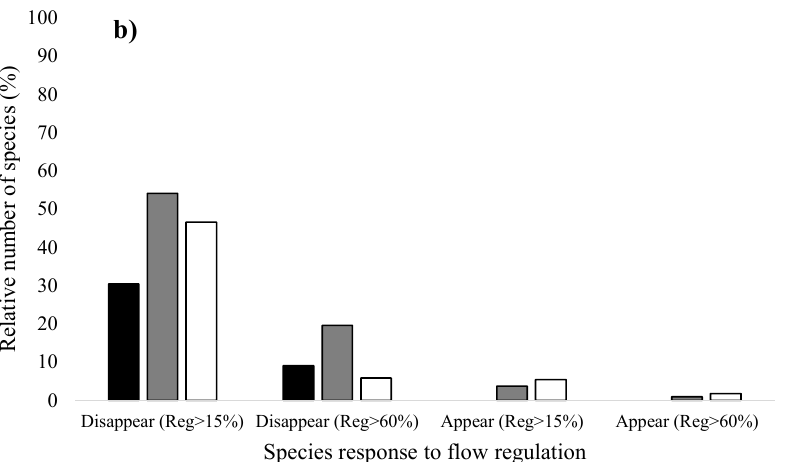
Figure 3. Fraction of species separated by their response to flow regulation for each life form group. ( a ) Fraction of the total species pool which showed negative, positive, or impassive responses to increasing degrees of regulation. ( b ) A specification of the above showing the fraction of total species that disappeared or appeared at reaches with beyond moderate flow regulation (>15%) or in the high flow regulation category (>60%).